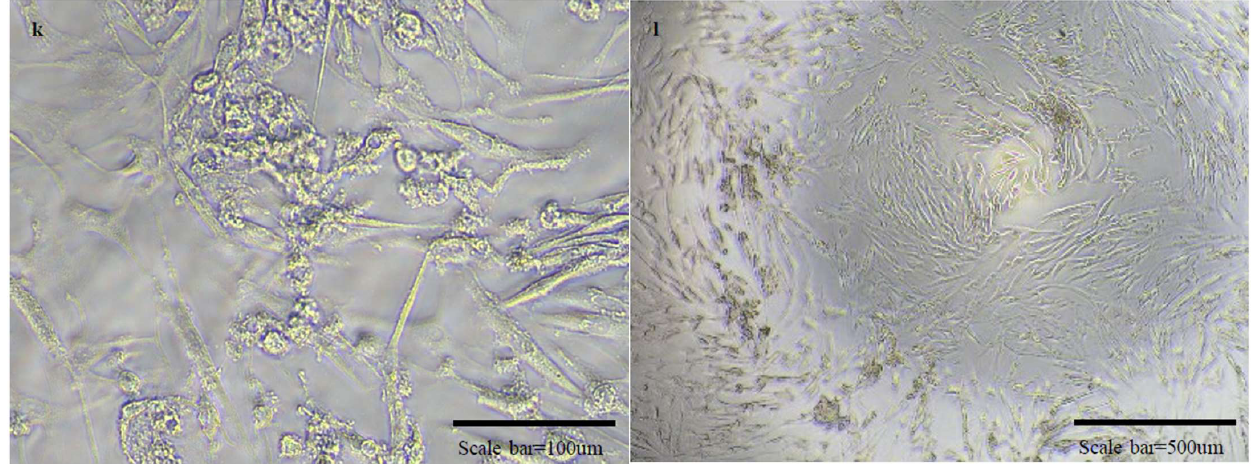
Figure 5. Micrographs of cells in normal state and cells with cytopathic effects due to viral infection. There are micrographs of SARS-CoV-2/Vero ( a – d ), OC43/HCT-8 ( e – h ), and 229E/MRC-5 ( i – l ) in order. There are high magnification micrographs (200 × ) of normal state ( a , e , i ) and cytopathic effect ( c , g , k ) cells. There are low magnification micrographs (40 × ) of normal state ( b , f , j ) and cytopathic effect ( d , h , l ) cells. In the SN test conducted additionally using OC43 and 229E viruses, cross-protection was not shown.